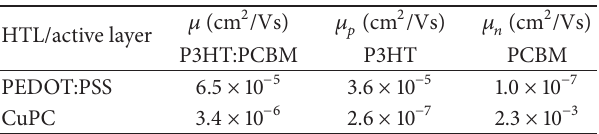
Table 3: Mobility of holes (in P3HT films) and electrons (in PCBM films) and mean mobility of carriers in the P3HT:PCBM blends, estimated from impedance measurements using ITO/HTL/active layer/Al structures.